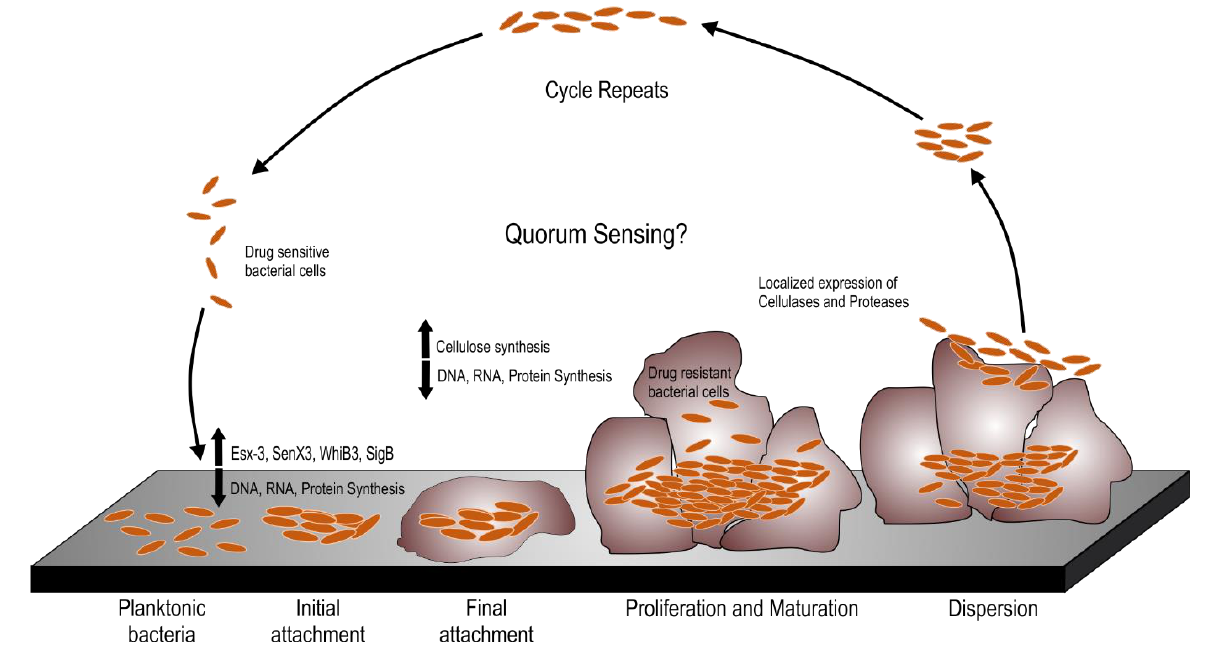
FIGURE 1: The biofilm formation and dispersal cycle. The planktonic bacteria form biofilms through a series of steps, which involve the initial attachment of the cells to a substratum followed by biofilm maturation and proliferation of bacteria within the matrix and finally a part of the matured biofilm dispersing to another site for subsequent localization and attachment. During this process, bacteria undergo phenotypic changes. Several genes playing roles in virulence and redox sensing are upregulated. Biofilms formation is associated with up- regulation in cellulose synthesis during maturation of the biofilms; however, localized expression of cellulases and proteases degrades the extracellular the matrix of the biofilm thereby leading to bacterial dispersal followed by start of a new cycle of biofilm